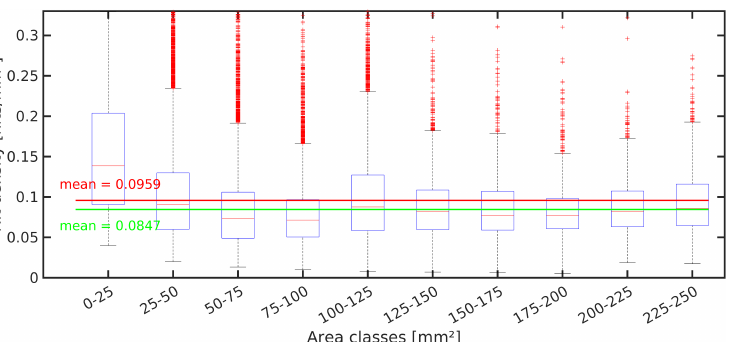
Figure 8. Statistics of hit density of half-ellipsoid triangles. Visualization of the median and mean hit density along 10 area classes from zero to a maximum of 250 mm 2 and a bin width of 25 mm 2 . The low variance between the individual mean and median values to the overall values proves that there is—as expected—a constant relation relation between the size of the triangles and the observed hit density. The hit density of a “fully visible” triangle is ρ m = 0.0959 hits/mm 2 . Table 2. Overview of the faces ( F ) and areas ( A ) that are “visible” to laser scanner in original (unper- turbed) plant models as relative ratios to their known full-plant values, i.e., F vis / F all re. A vis / A all . Species Visible Faces [% ] Visible Area [%] Tomato 0.59 0.78 Arabidopsis 0.79 0.81 Maize 0.67 0.94 Cucumber 0.48